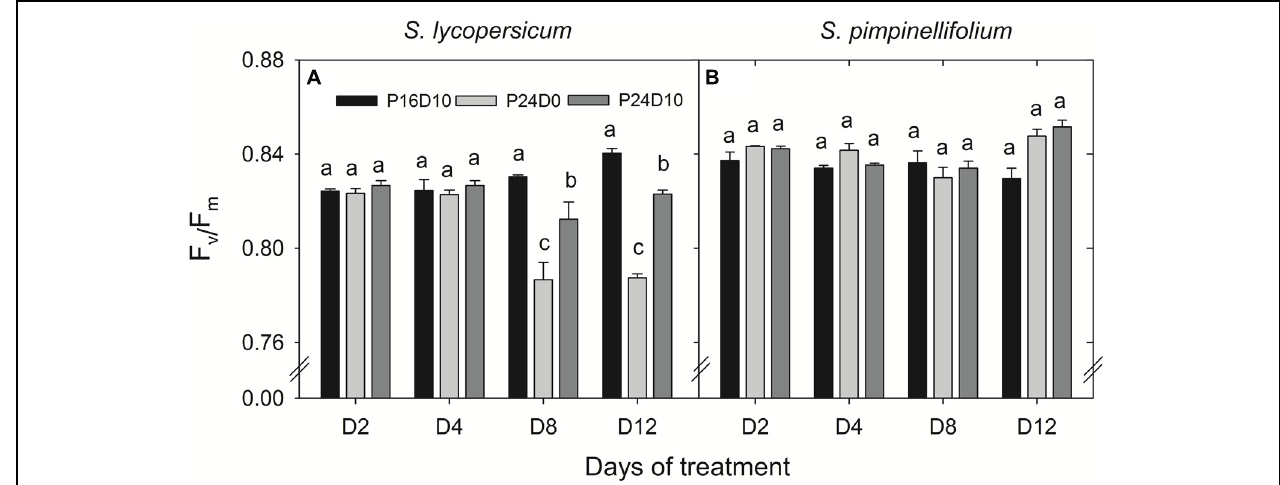
FIGURE 2 | Response of F v /F m in S. lycopersicum (A) and S. pimpinellifolium (B) at different days (D) under P16D10, P24D0, and P24D10 growth conditions. The F v /F m data were taken at 21:30 CEST. Vertical bars are SEM ( n = 3). Treatment means with different letters within each day are significantly different. The statistical analysis was done by the Tukey and Waller–Duncan k-ratio t -test.